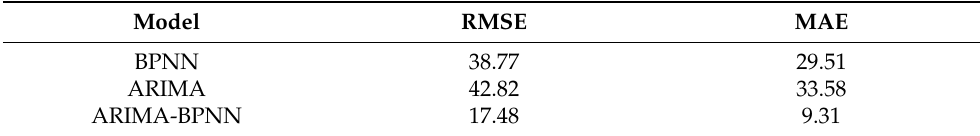
Table 3. Evaluation index values of each